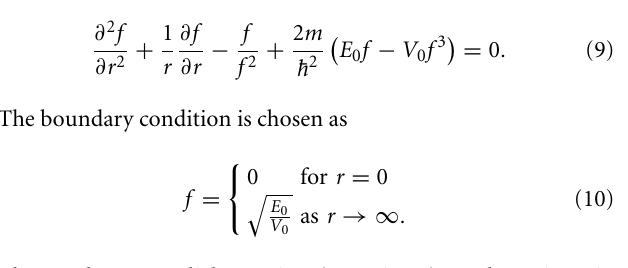
the GP equation as the bosons are in a condensed state. The wave- function ψ is normalized to the total number of particles N